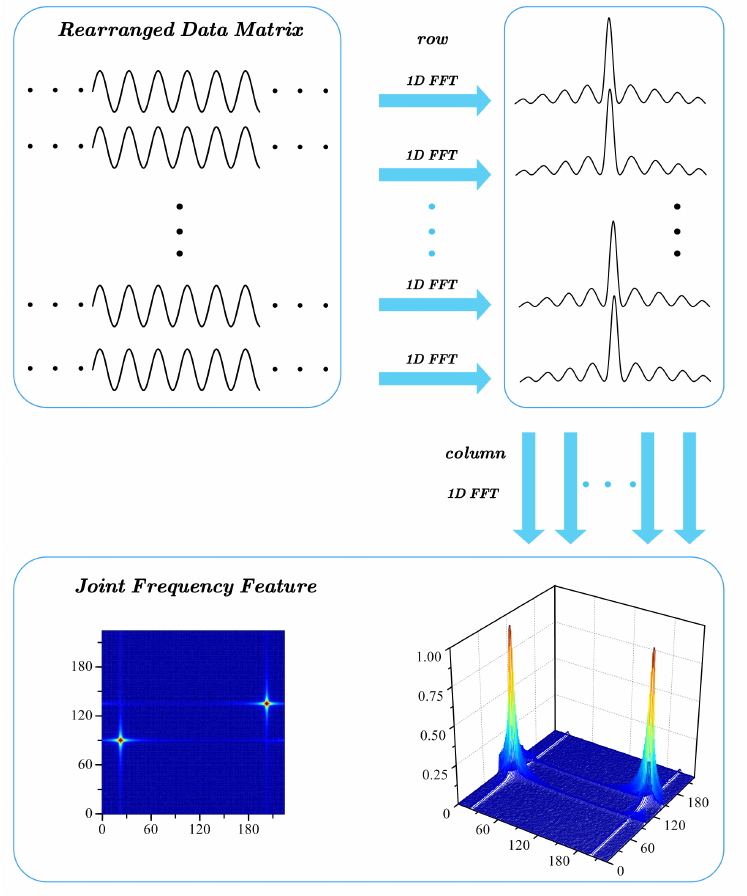
Figure 2. Two-Dimensional FFT of the data